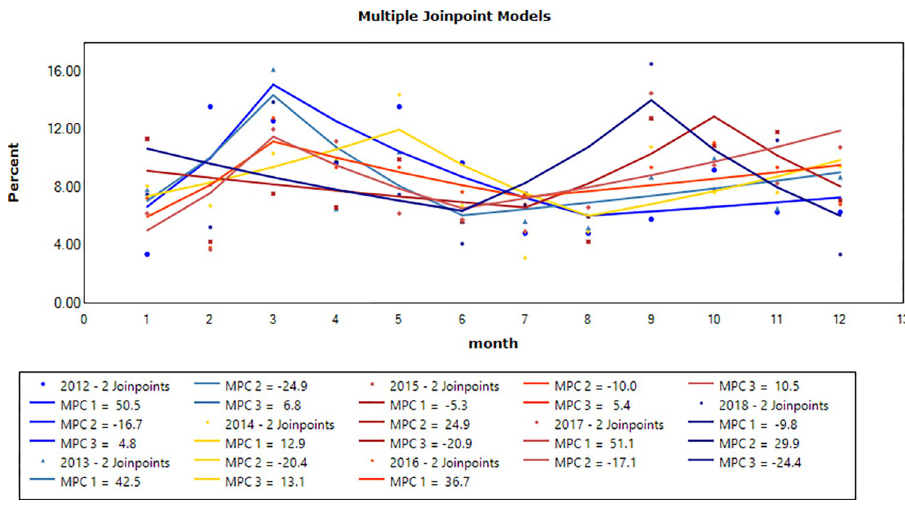
Fig 3. Temporal distribution of reported cases of pulmonary tuberculosis cases by year among students in Nanning, from 2012 to 2018.